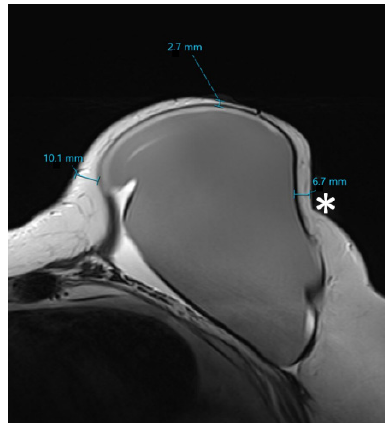
Figure 2. Skin flap measurement acquisition in T2-weighted image. Thickness measurements of retromamillary skin flap and at 3 and 9 o’clock. Measurements were performed using the integrated measurement tool of the Picture Archiving and Communication System (SECTRA AB, IDS7 Version 22.1, Linköping, Sweden).